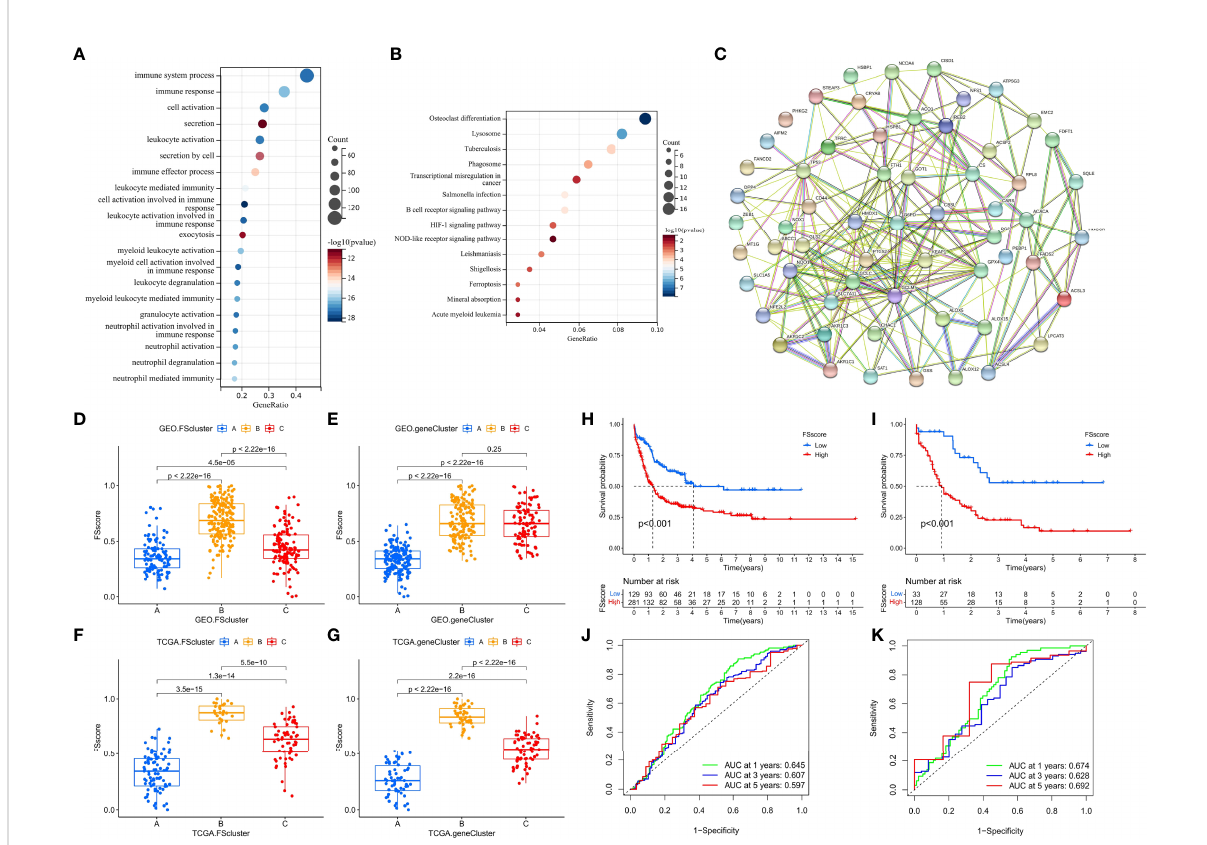
FIGURE 5 Analysis TME characteristics associated with ferroptosis-related phenotypes. (A, B) GO annotation and KEGG pathway enrichment analysis showed the functions of the ferroptosis-related phenotype signature genes. (C) PPI network of ferroptosis-related phenotype signature genes. (D – G) Differences in the FSscore of ferroptosis-related molecular patterns and genomic subtypes in GEO and TCGA groups, Kruskal – Wallis test. (D – I) Differences in the survival of patients in high and low FSscore groups in the GEO and TCGA cohorts, (H) : GEO group, (I) : TCGA group, log rank test. (J, K) The ROC curves showed the speci fi city and sensitivity of the FSscore; (J) : GEO group, (K) : TCGA